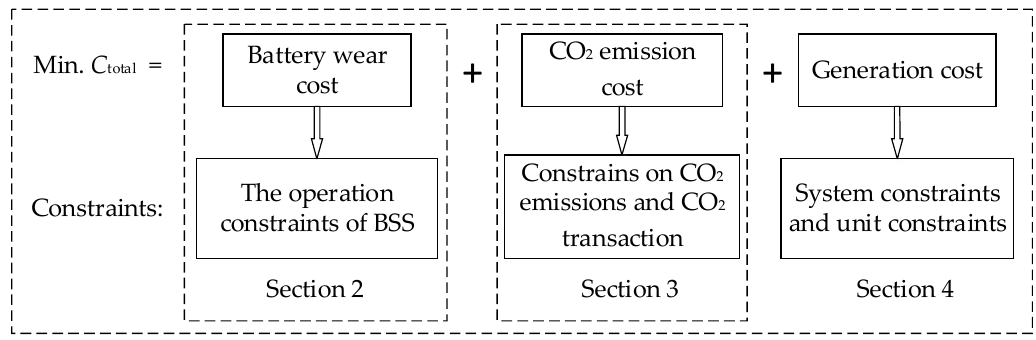
Figure 1. Framework of the proposed model .